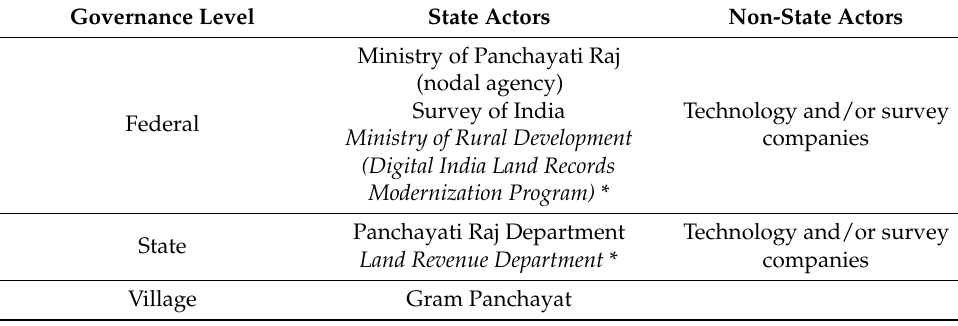
Table 5. Decentralized land administration structure for